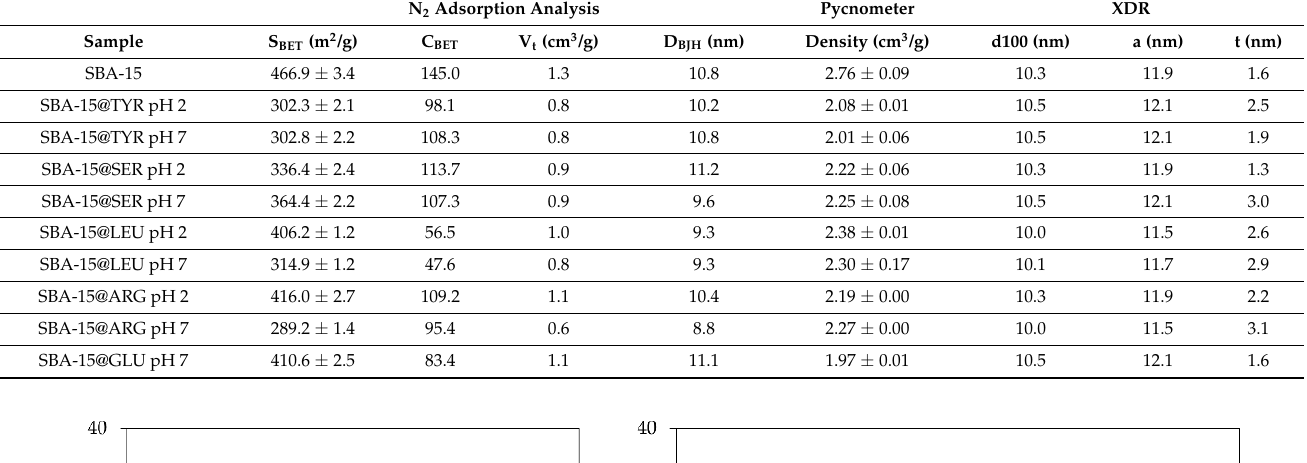
Figure 6. Nitrogen isotherms at 77K of bare SBA-15 (black) and functionalized SBA-15@AA at pH2 ( a ) and pH7 ( b ).